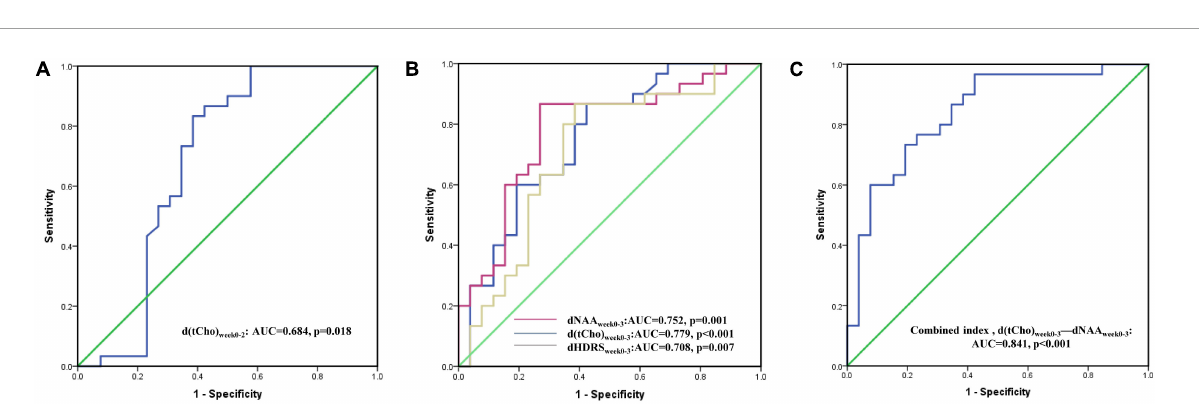
FIGURE6 (A–C) ROC curves of hippocampal metabolites predictors in the second and third week are presented. ROC, receiver operating characteristic. AUC, area under curve; NAA, N-acetyl-aspartate; tCho, phosphocholine and glycerophosphocholine; HDRS, Hamilton Rating Scale for